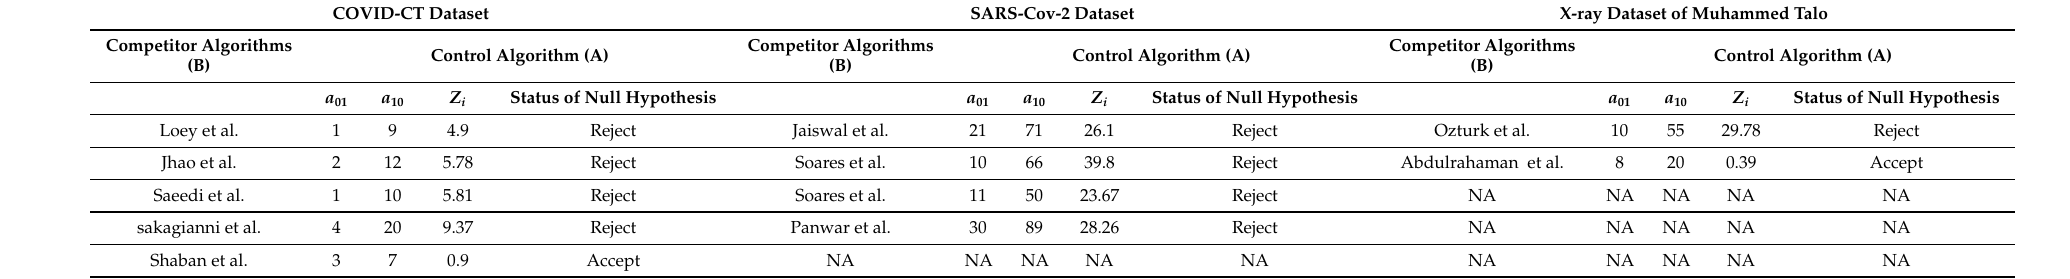
Table 13. Statistical comparison using McNemar’s test of our proposed CGRO algorithm with some existing SER